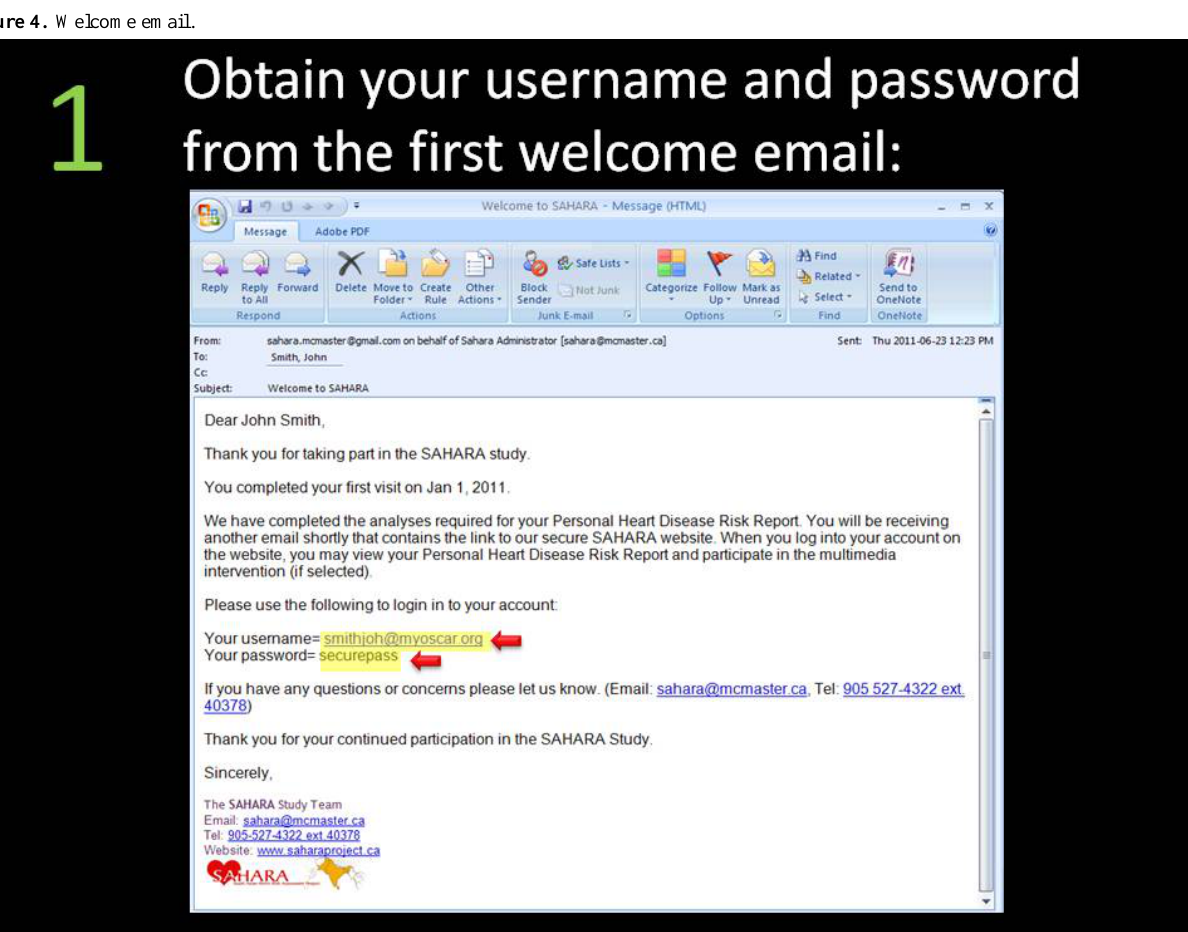
Figure 4. Welcome